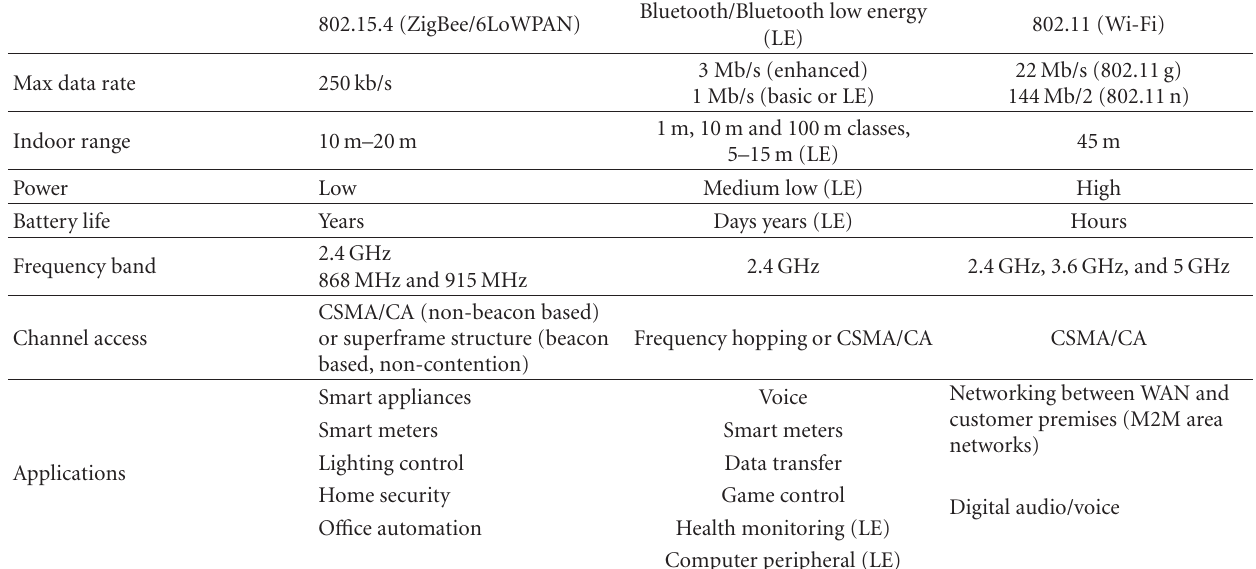
Table 1: M2M short range wireless technology (adapted from